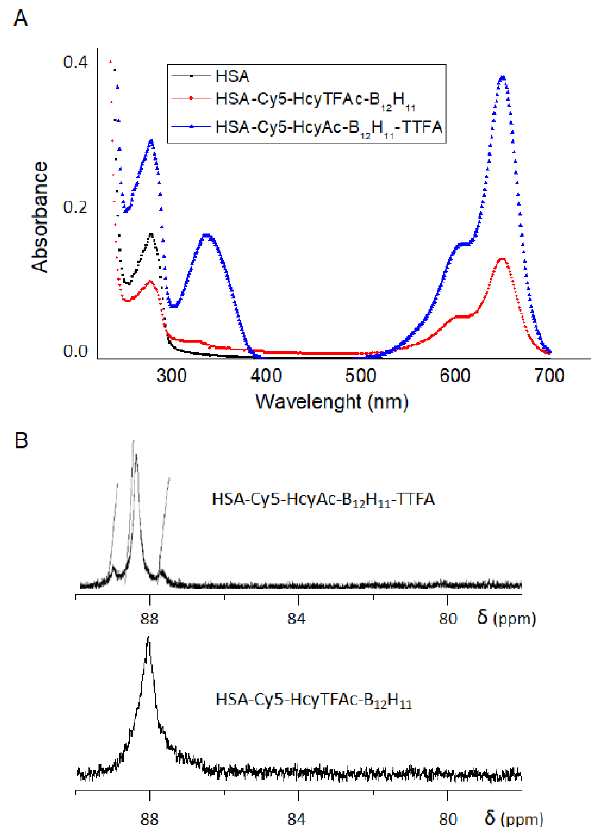
Figure 2. Characteristics of multifunctional human serum albumin conjugates. ( A ) UV-vis spectra of HSA and boronated albumin theranostic conjugates in PBS buffer, pH 7.4. HAS — black; HSA-Cy5-HcyTFAc-B 12 H 11 — red; HSA-Cy5-HcyAc-B 12 H 11 -TTFA — blue. ( B ) 19 F NMR spectrum (at 282.4 MHz) of HSA-Cy5-HcyAc-B 12 H 11 -TTFA (0.6 mM) and HSA-Cy5-HcyTFAc-B 12 H 11 (0.3 mM) in PBS buffer (pH 7.4; to provide deuterium lock, D 2 O was added to 20% of the total volume) at 37 °C. The chemical shifts are referred to the resonance of C 6 F 6 at 0.0 ppm.